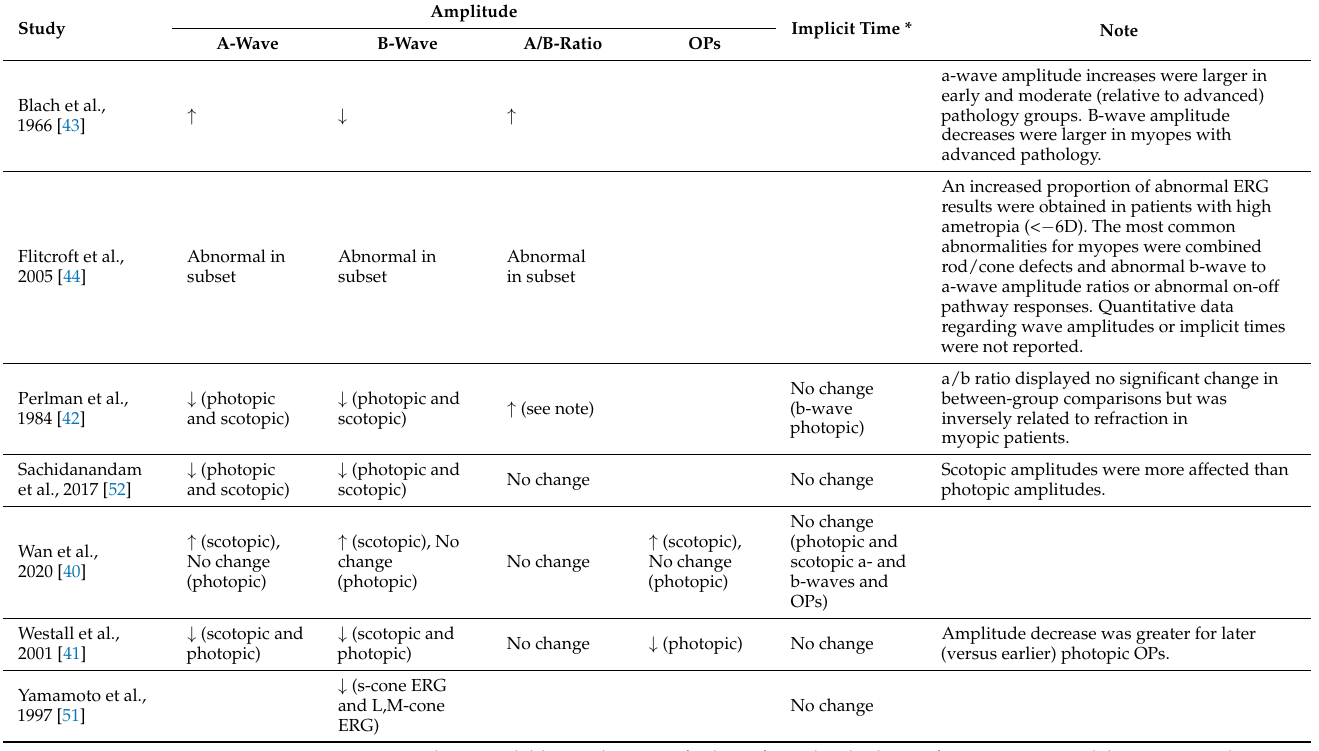
Table 7. ERG Results of Studies Assessing